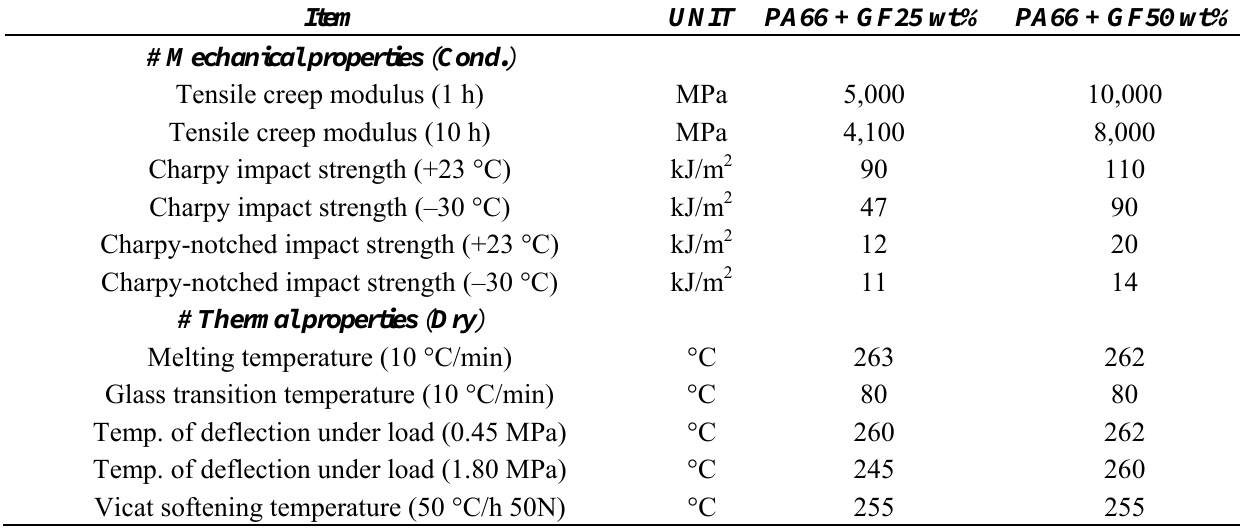
Table 2. Material properties of the glass fiber-reinforced polyamide according to fiber contents. # Mechanical properties ( Cond. )